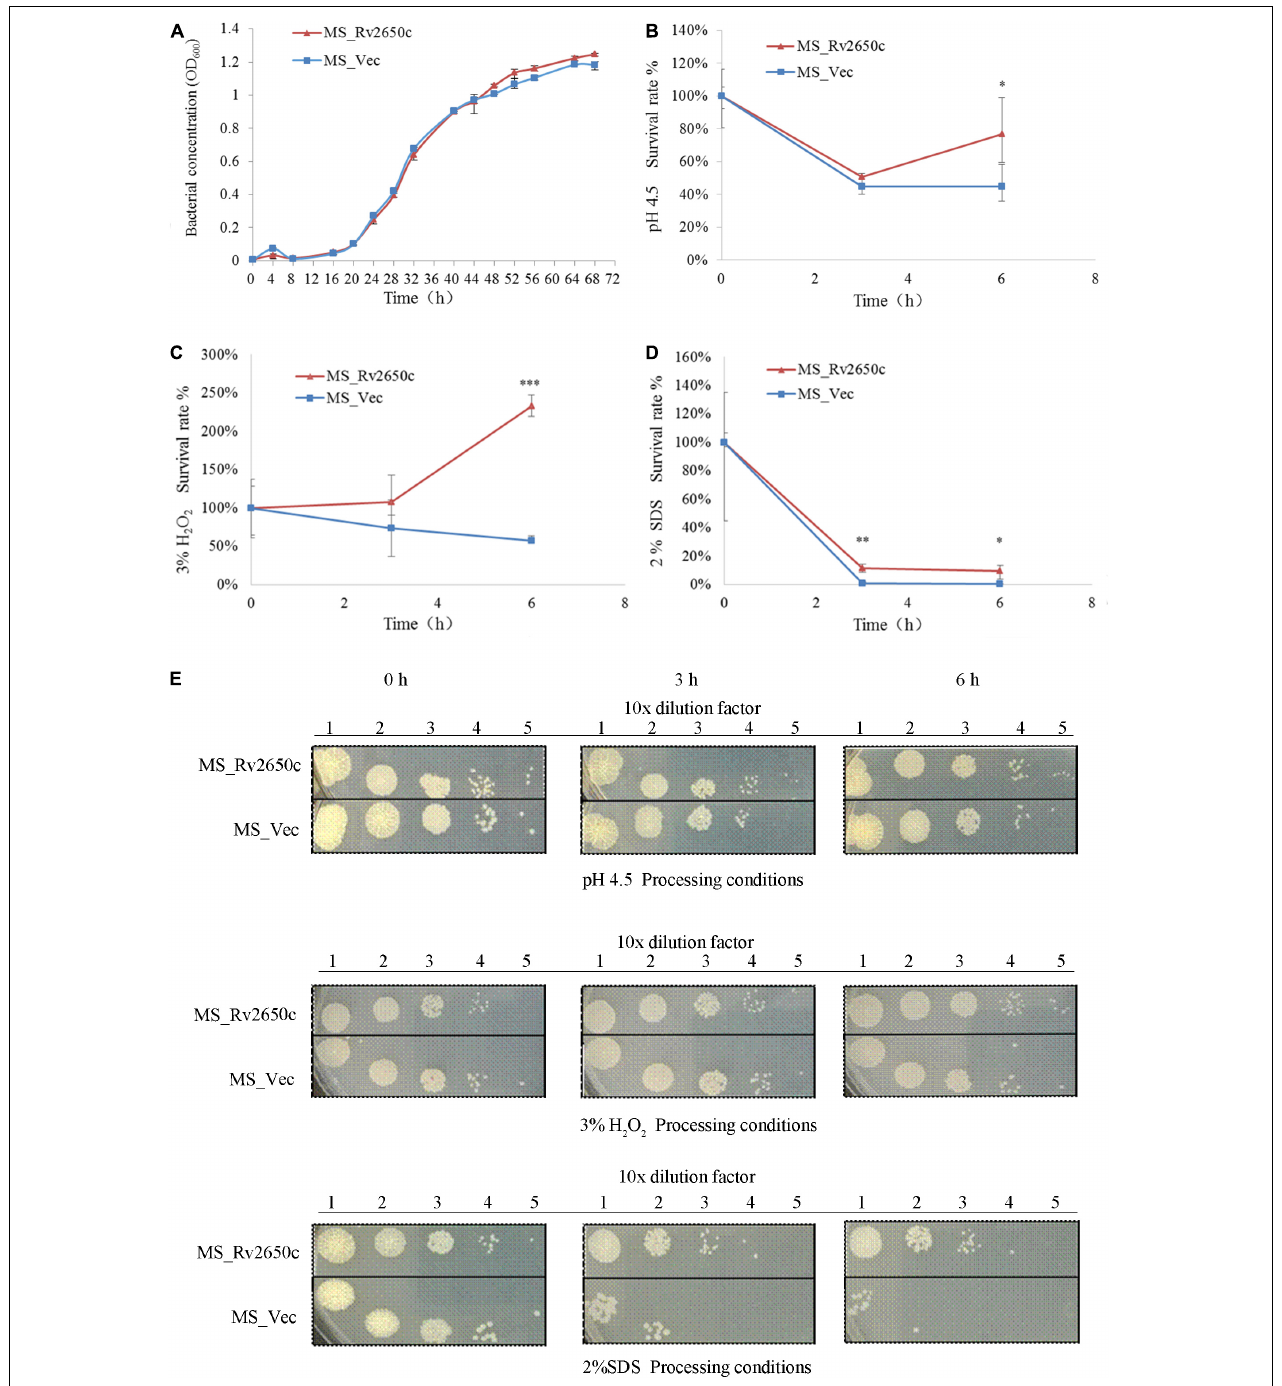
FIGURE 3 | Extracellular growth and stress analysis results of recombinant M. smegmatis . (A) MS_Rv2650c and MS_Vec were inoculated into MB 7H9 broth and cultured. The OD 600 value was monitored at 4 h intervals for a total of 68 h. (B) Inoculate MS_Rv2650c and MS_Vec into 7H9 broth at pH 4.5 for 6 h at 37 ◦ C. The cultured solution of 0, 3, and 6 h was diluted and coated on MB 7H9 plate, and the number of single colonies was calculated after incubation at 37 ◦ C for 3–4 days. (C) MS_Rv2650c and MS_Vec were treated with 3% hydrogen peroxide at 37 ◦ C for 6 h in a cultured solution with an OD 600 about 0.5, and the cultured solution of 0, 3, and 6 h was diluted and coated on the MB 7H9 plate. The number of single colonies was calculated after incubation for 3–4 days at 37 ◦ C. (D) MS_Rv2650c and MS_Vec were treated with 2% SDS for 6 h at 37 ◦ C in a cultured solution with an OD 600 about 0.5, and the cultured solution of 0, 3, and 6 h was diluted and coated on the MB 7H9 plate. The number of single colonies was calculated after incubation for 3–4 days at 37 ◦ C. (E) MS_Rv2650c and MS_Vec were diluted and coated on 7H9 plates under the conditions of pH 4.5, 3% H 2 O 2 , 2% SDS, and cultured at 37 ◦ C for 3–4 days. Similar results were obtained in 3 independent experiments. (* p < 0.05; ** p < 0.01; *** p < 0.001).